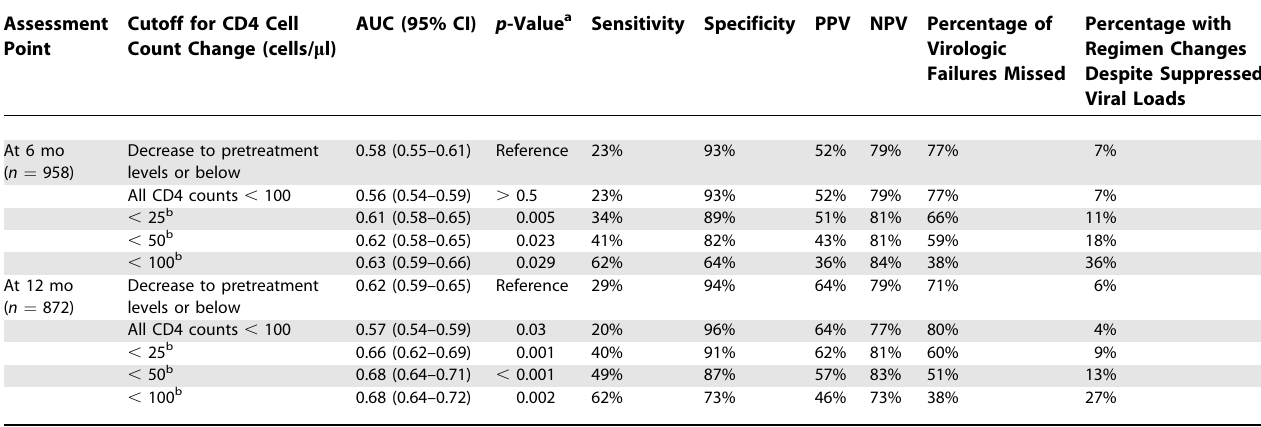
Table 2. Test Characteristics for CD4 Cell Count Changes for Identifying Patients with Virologic Failure after Initiating cART when